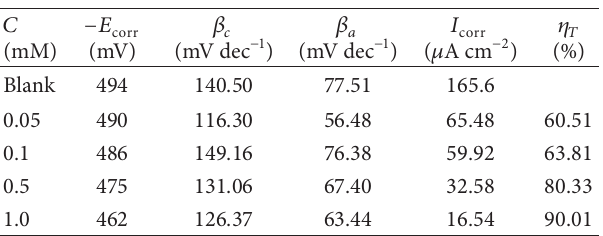
Table4:Polarizationparametersofmildsteelin1 MHClcontaining different concentrations of RS.